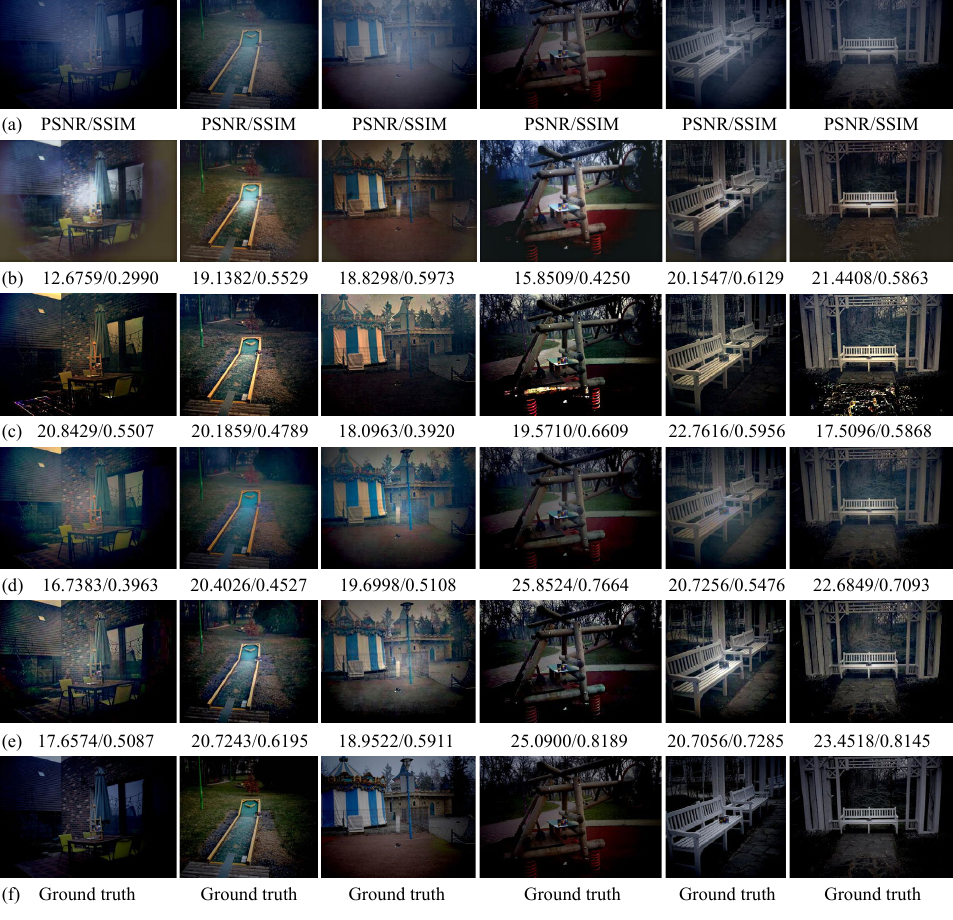
Figure 8. Results on synthetic outdoor dataset O-Haze [31]. ( a ) Input images; ( b ) Results of Qu et al. [22]; ( c ) Results of Li et al. [15]; ( d ) Results of Zhang et al. [18]; ( e ) Results of ours; ( f ) Ground truth images. Table 3. Comparison result on synthetic